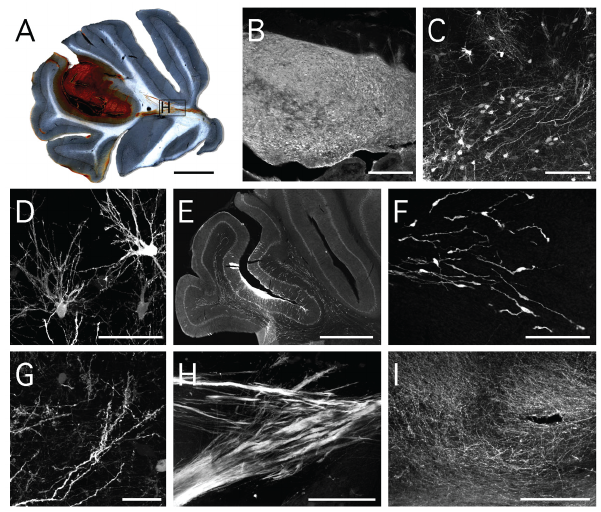
Figure 5. Structure and morphology of FA-iPS donor grafts revealed by immunohistochemistry for GFP. ( A ) Darkfield imaging of a representative section illustrates the size and placement of the grafts within the cerebellum. ( B ) The GFP + cells were distributed uniformly throughout the grafts. ( C , D ) less densely packed cells adjacent to graft had morphological features consistent with differen- tiated neurons and glia. ( E , F ) cells with the morphology of migrating neuroblasts could be found throughout the cerebellar white matter. GFP + fibres appeared in various forms including ( G ) spiny dendrites, ( H ) fasciculated bundles and ( I ) dense networks within the cerebellar grey matter. Scale bars: A, E - 1 mm; B, H, I – 200 m m; C, F – 100 m m; D - m m; G – 25 m